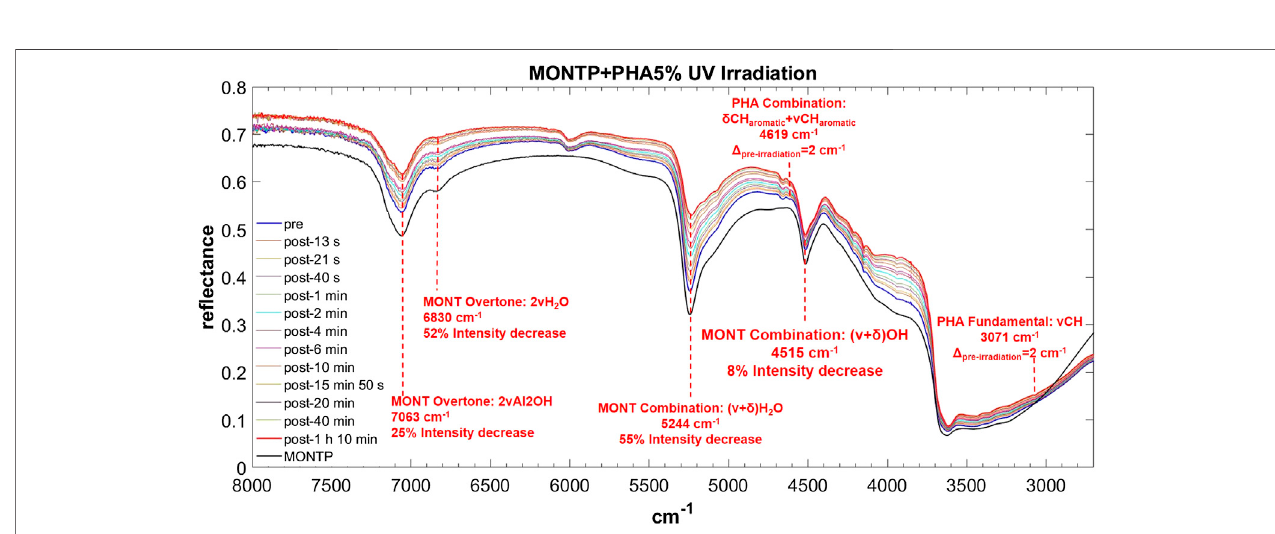
FIGURE 11 | Main changes in NIR features after 70 min of UV irradiation for PHA 5 wt% on montmorillonite containing 1 wt% of Mg-perchlorate. Legend: Δ pre-irr (cid:2) wavenumber shift with respect to the same peak pre-irradiation; ν (cid:2) stretching vibrational mode; δ (cid:2) bending vibrational mode.